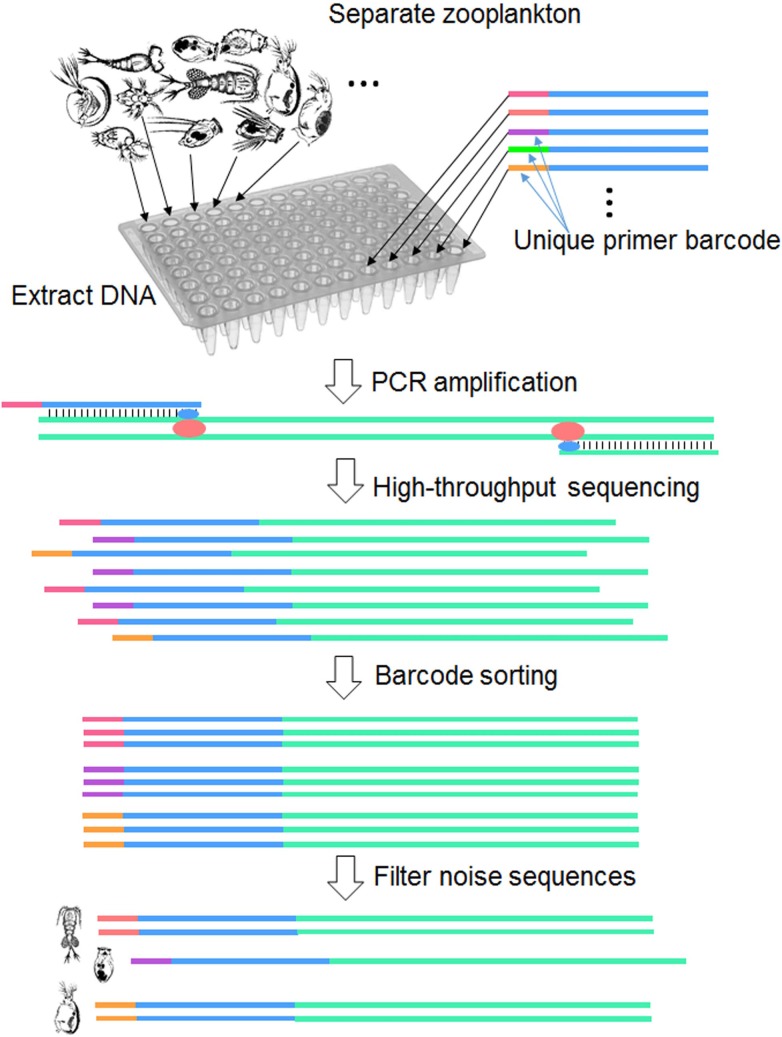
Schematic diagram of parallel barcode recovery using a high throughput sequencing protocol.